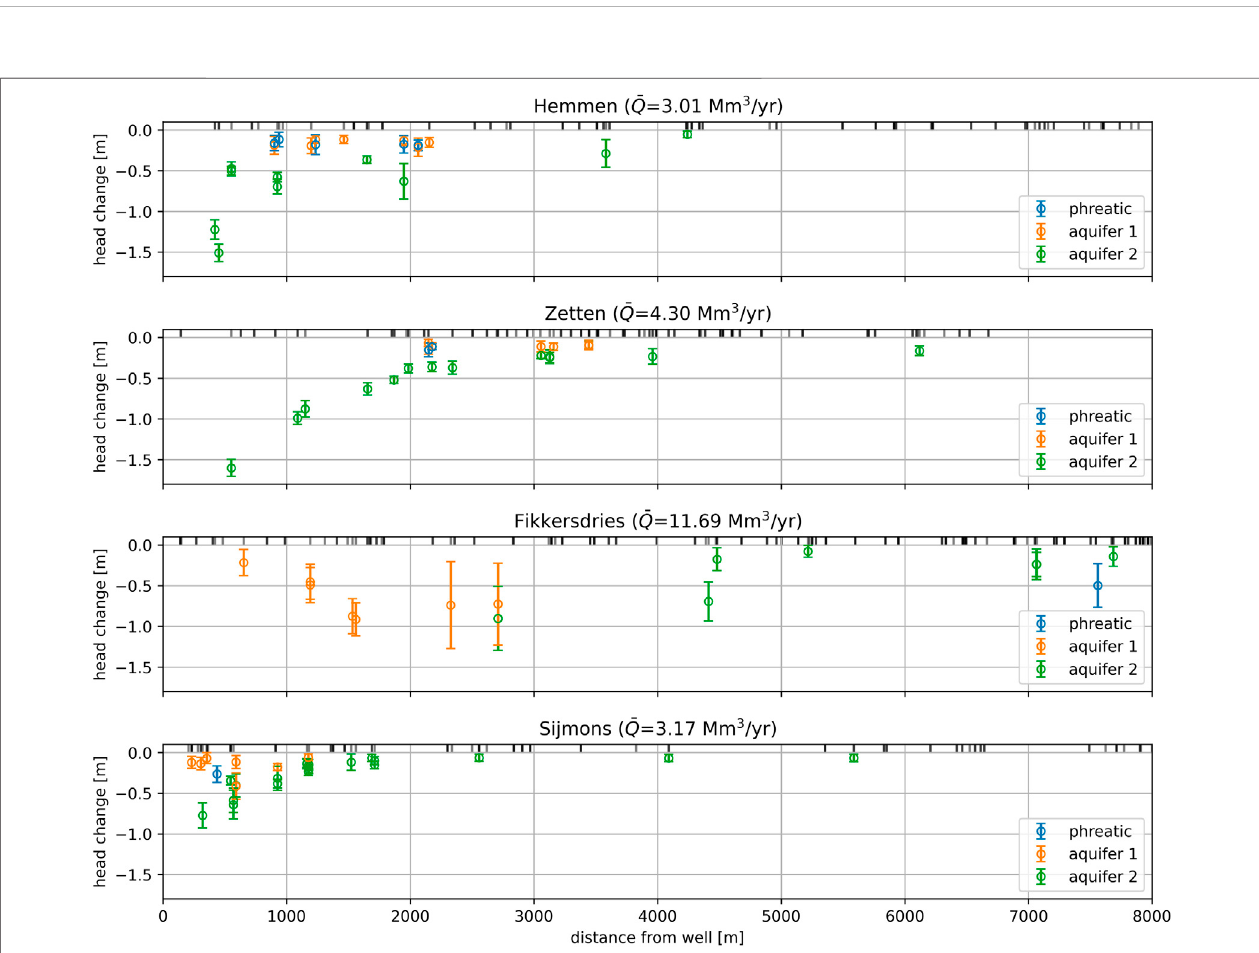
FIGURE 6 | The estimated steady state head change versus the distance between the well fi eld and the observation well using the average pumping rate ( (cid:1) Q ) between2015and2020foreachwell fi eld.Uncertaintybarsare2timestheestimatedstandarddeviation.Theblackticksatthetopofeachgraphindicatethedistances at which an observation well is present but either none of the model structures was reliable or the well fi eld was not included in the selected model structure.